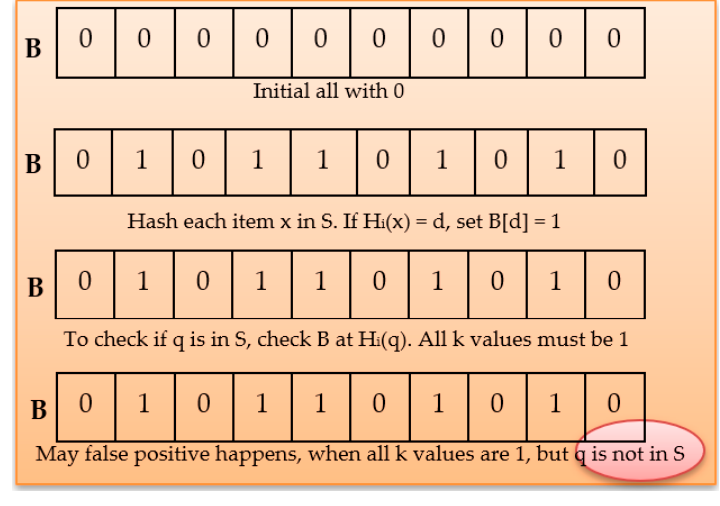
Figure 3. Standard Bloom Filters.